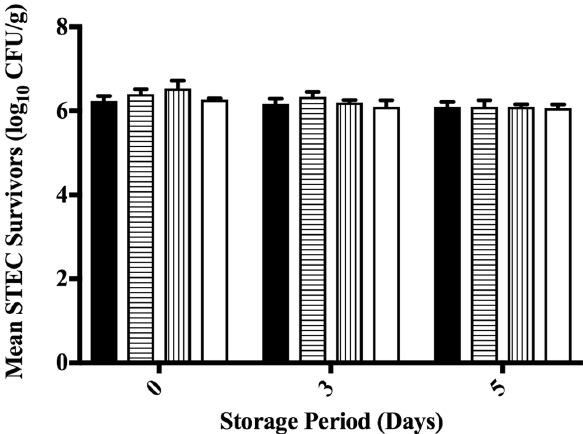
Figure A1. Least squares LS means of Shiga toxin-producing Escherichia coli (STEC) as a function of the interaction of antimicrobial treatment x storage period ( p = 0.812; pooled SE = 0.164). Error bars depict one standard error for treatment mean; means were determined by two ‐ way analysis of variance (ANOVA) and Tukey’s Honestly Significant Differences (HSD) means separation test. Beef trimmings were ground through a 3/8 ‐ inch plate following antimicrobial intervention, separated into 10.0 g samples, and stored for up to 5 days at 5 ± 1 °C prior to STEC enumeration on Petri dishes containing tryptic soy agar supplemented with 100.0 μ g/mL of rifampicin. Antimicrobial treatments were: 25 °C sterile water spray (filled bars), free eugenol applied at twice the MIC in vitro against STEC (horizontally hashed bars), SDS micelle ‐ loaded eugenol applied at three times in vitro MIC (vertically hashed bars), and 2% lactic acid pre ‐ warmed to 55 °C (open bars).